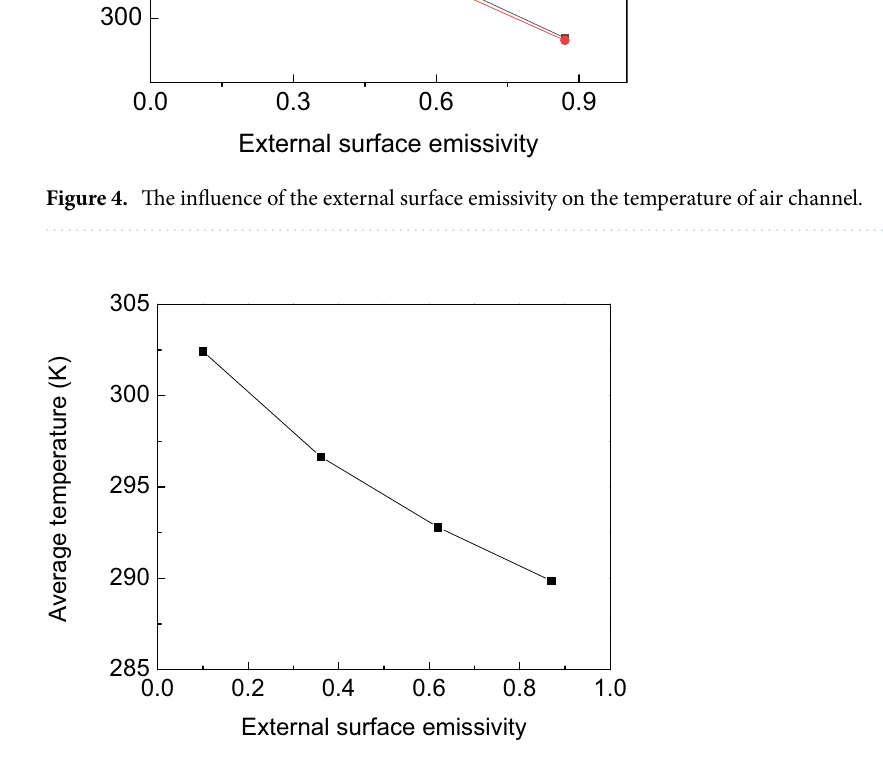
Figure 5. Effect of the external surface emissivity of the porous wall on indoor average